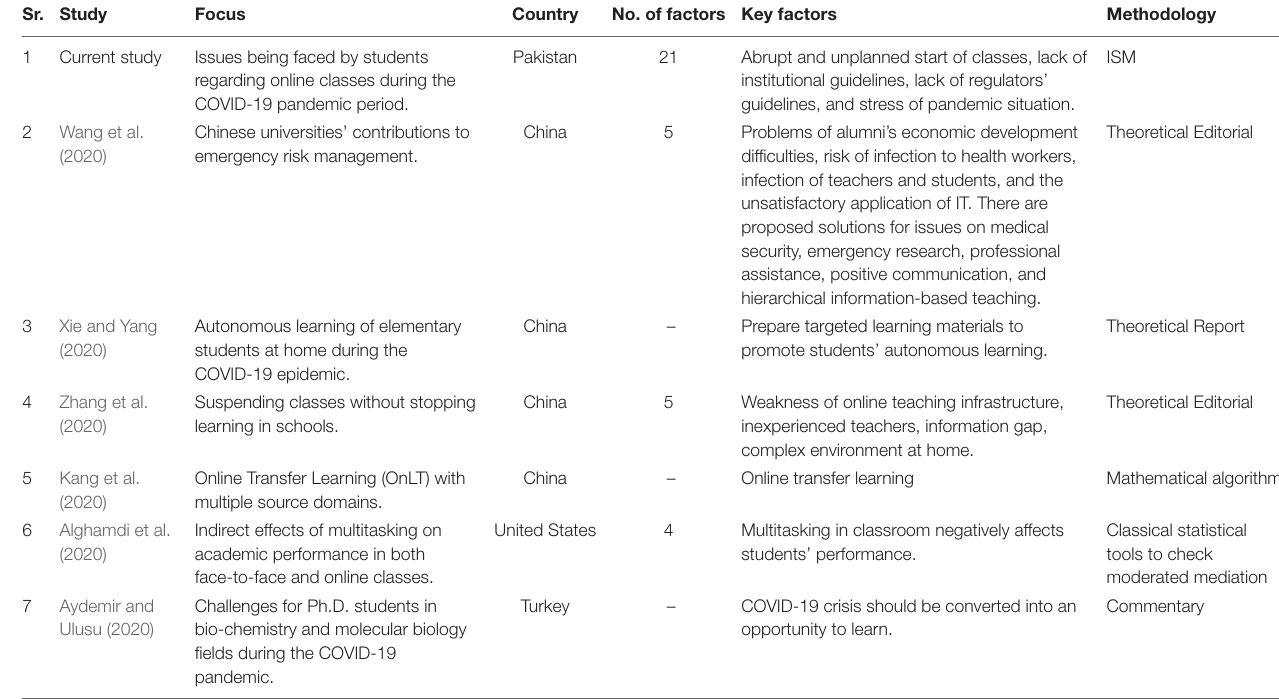
TABLE 6 | Contrasting results of the study with contemporary